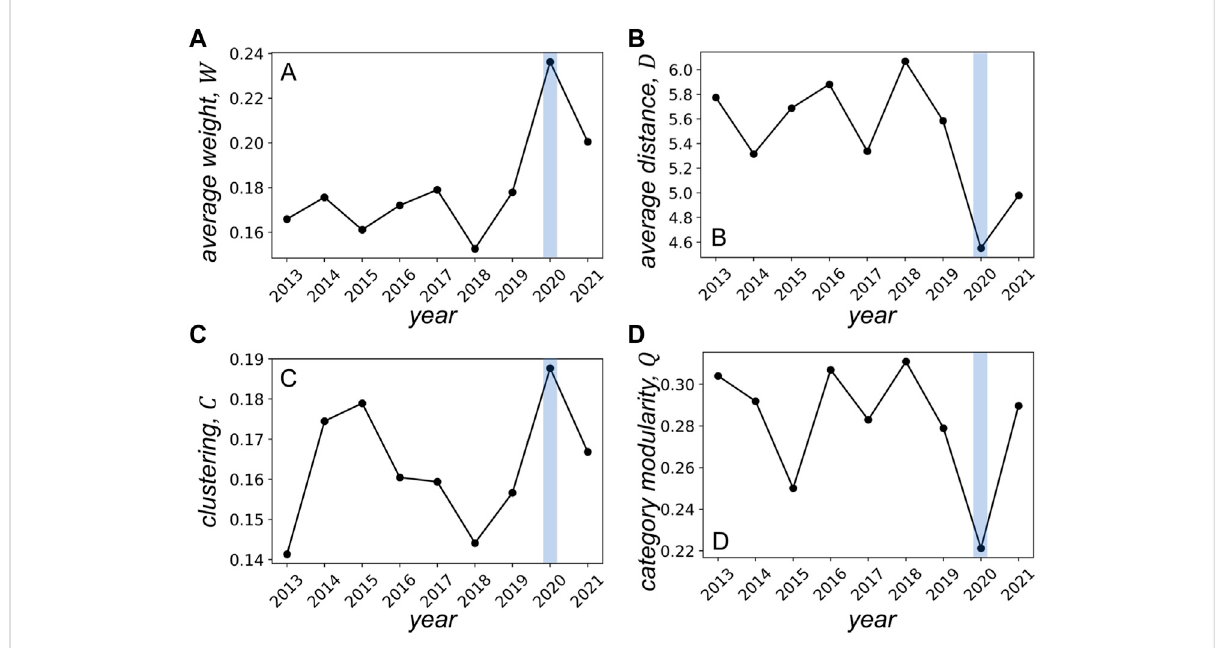
FIGURE 3 Average weight (A) , average distance (B) , clustering coef fi cient (C) , and category modularity (D) of the yearly DCCA network of commodity future